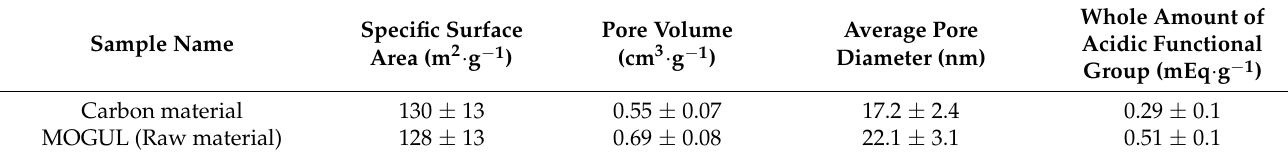
Table 1. Properties of the carbon